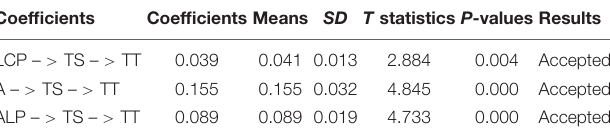
TABLE 8 | Indirect